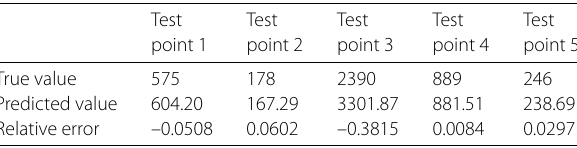
Table 3 The relative error of each point in the test